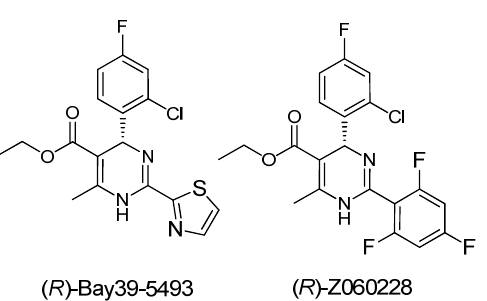
Figure 1. Structures of HAP analogs.